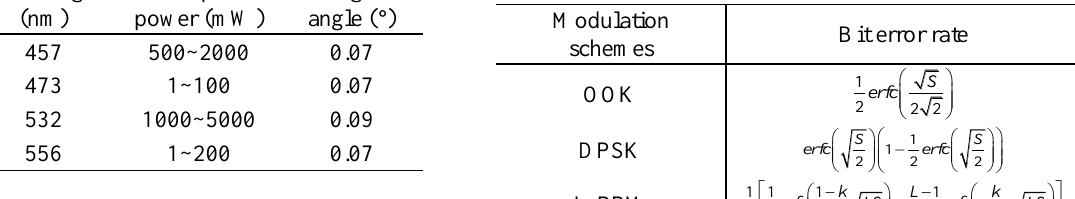
Table1. Characteristics of laser in blue-green